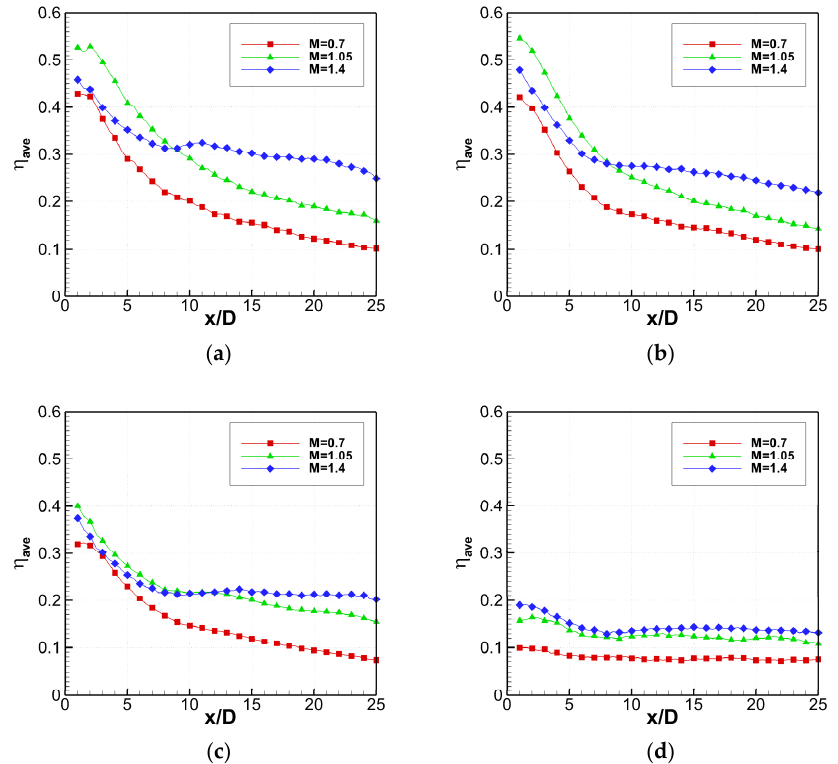
Figure 14. Spanwise averaged film effectiveness at different blowing ratios. ( a ) B = 0; ( b ) B = 0.2; ( c ) B = 0.5; ( d ) B = 0.8.